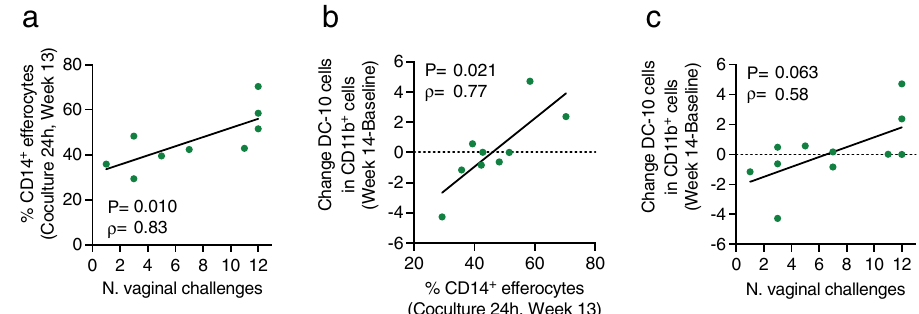
Fig.5|EfferocytosisandDC-10inStudy2.a Correlationbetweenthefrequencyof CD14 + efferocytes cocultured for 24h and Time of Acquisition (TOA) in n =9 vac- cinated animals (week 13). b , c Correlation between the change from baseline to week 14 in the frequency of DC-10 cells and the frequency of CD14 + efferocytes coculturedfor( b )24hin n =9vaccinatedanimals(week13)or( c )theTOAin n =11 vaccinated animals. Gating strategy: high SSC/single cells/Live/CD45 + /Lin